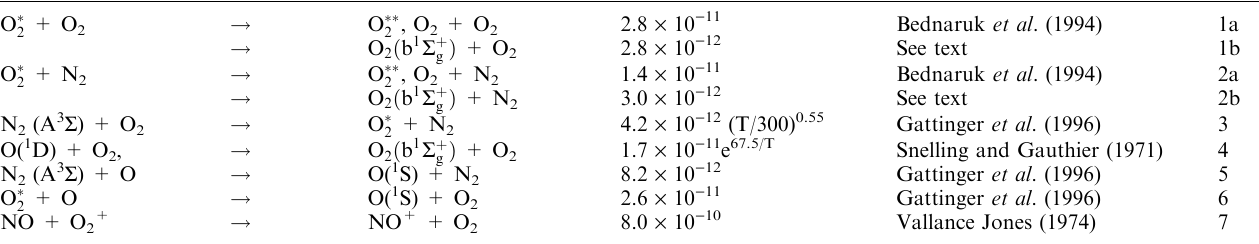
Table 1. Reaction rates used in the model, units are cm 3 molecule s )